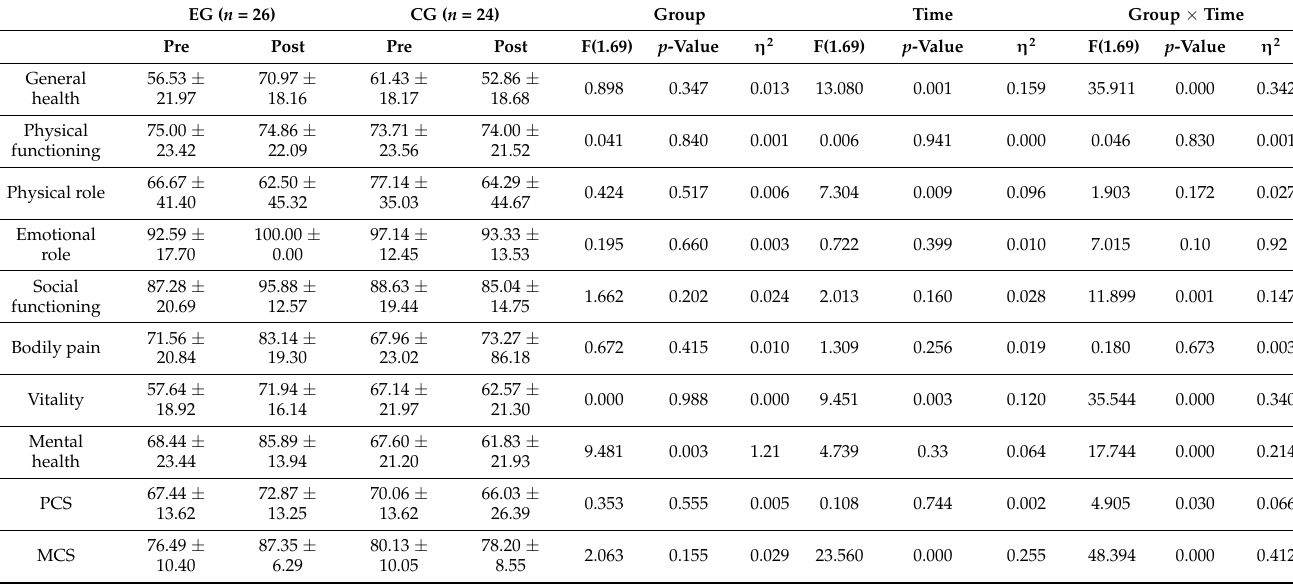
Table 3. Effects of the cognitive stimulation program on quality of